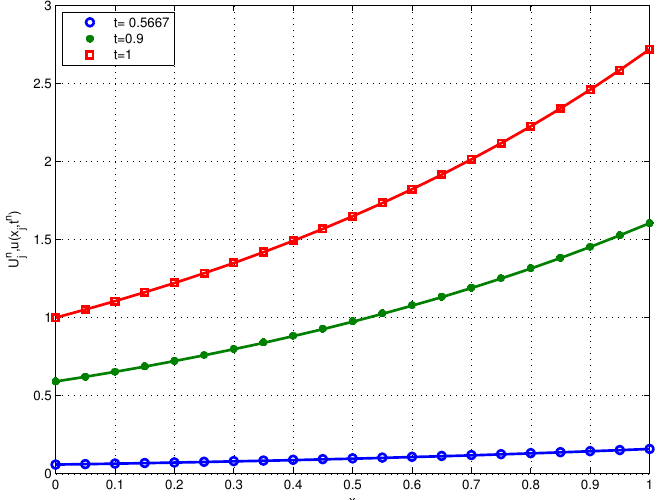
Figure 2. Comparison of the exact and the numerical solutions of the fractional partial differential equations (FPDE) (21) for α = 0.5 with N = J = 20 at different time steps. Solid lines: exact solution; star, circle and square points: numerical